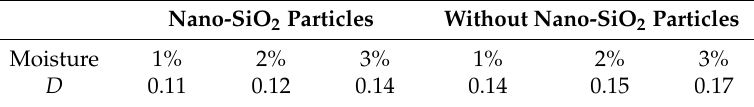
Table 4. Diffusion coefficients of water molecules (Å 2